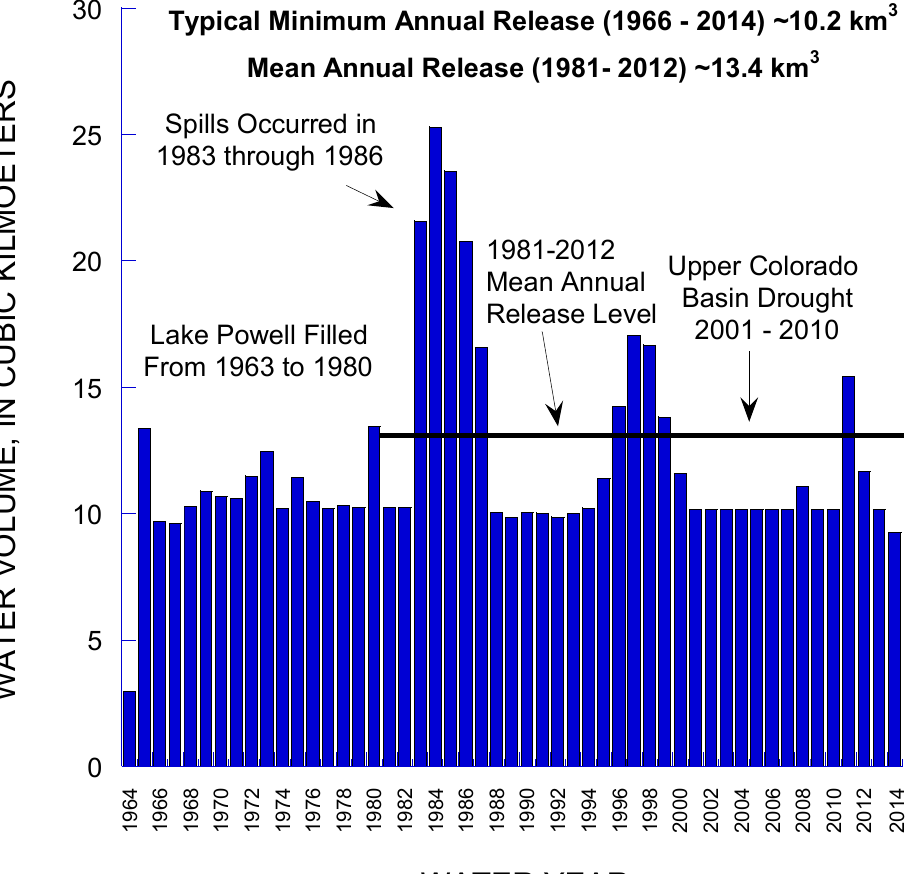
Figure A1.7. Annual water volumes released through Glen Canyon Dam from Lakes Powell to Mead (1964-2014) (data courtesy of R. Clayton and K. Grantz, written commun., 2014, U.S. Department of the Interior, Bureau of